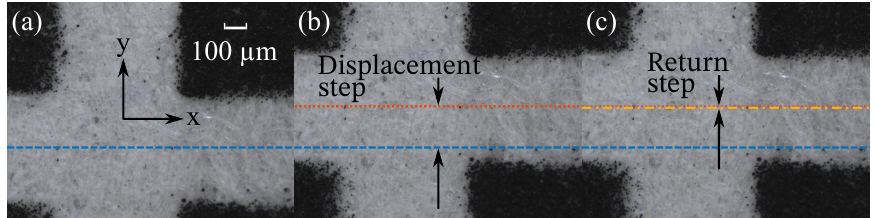
Figure 11. Object to be conveyed on the DAA ( a ), displacement step measure ( b ) and return step influence ( c ).